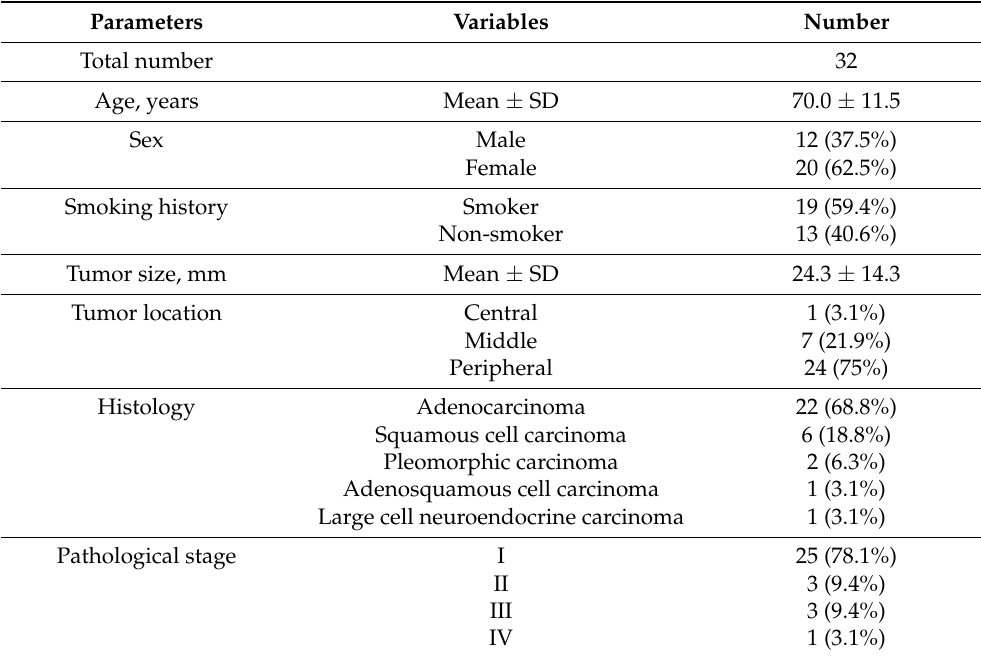
Table 1. Characteristics of the